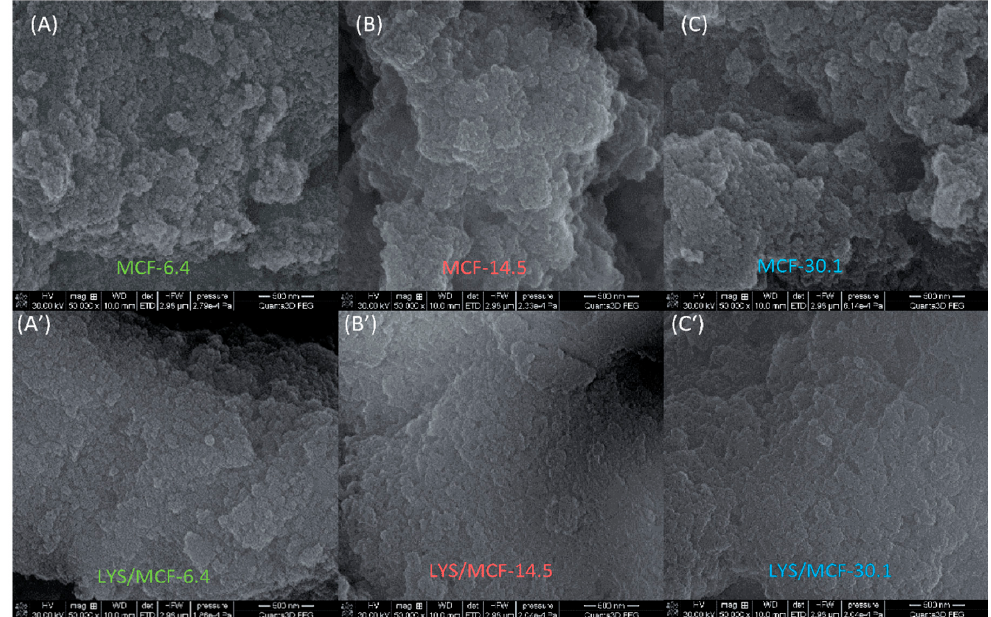
Figure 7. SEM micrographs of MCF-6.4 ( A , magnification 50,000), MCF-14.5 silica ( B , magnification 50,000), and MCF-30.1 ( C , magnification 50,000) and after protein adsorption ( A ’, B ’, C ’, magnification 50,000), respectively .